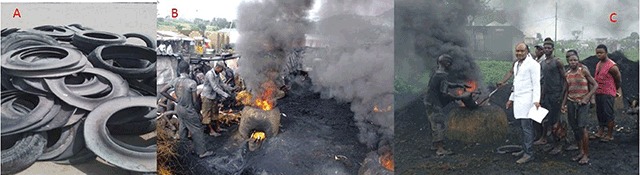
Scrap tyres and de-furring mounds utilized by butchers in meat processing at Dei-Dei abattoir, Abuja. (A) Scrap tyres ready for use in the abattoir. (B) De-furring mound for processing slaughtered animals with scrap tyres. (C) Butchers de-furring goat with F.O.O. inset.